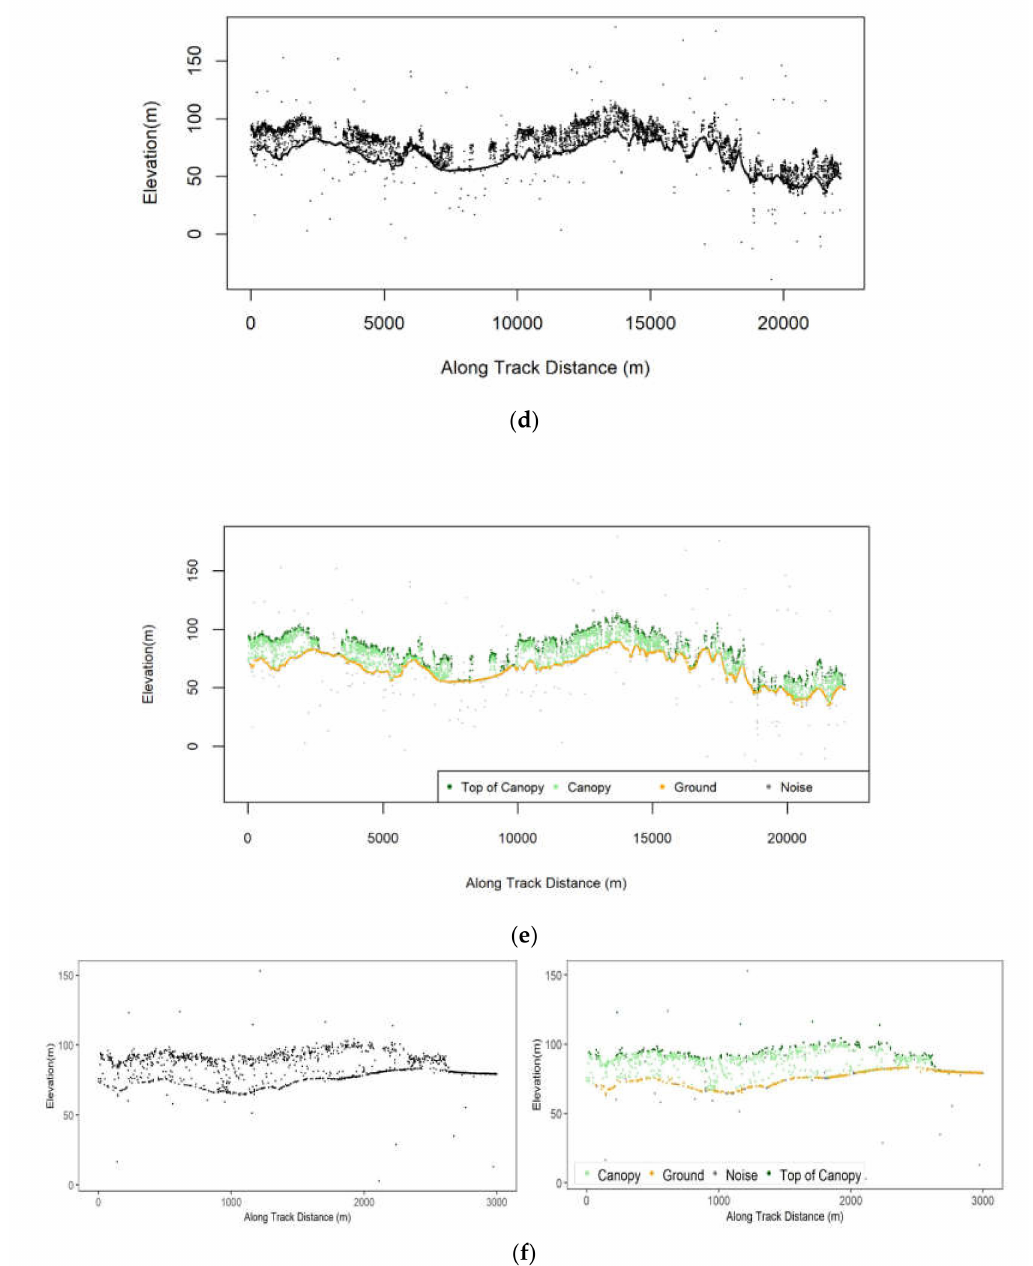
Figure 3. ( a ) Profile of raw ICESat-2 (ATL03) data from the strong beam of track 3 (GT3R) over temperate forests in southeast Texas; ( b ) profile of filtered and classified data from GT3R; ( c ) raw and processed ICESat-2 data for a subset of the profile from the strong beam of track 3 (GT3R); ( d ) profile of raw ICESat-2 (ATL03) data from the weak beam of track 3 (GT3L) over temperate forests in southeast Texas; ( e ) profile of filtered and classified data from GT3L; ( f ) raw and processed ICESat-2 data for a subset of the profile from the weak beam of track 3 (GT3L) These data were acquired on 3 December 2018; granule ID